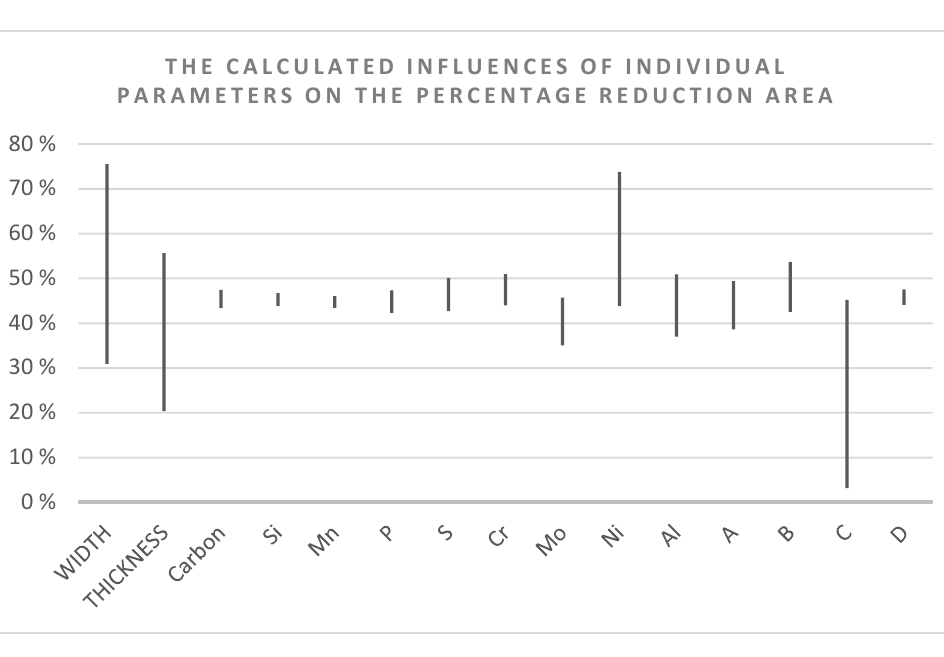
Figure 4. The calculated influences of individual parameters on the percentage elongation while separately changing individual parameter within the individual parameter range.